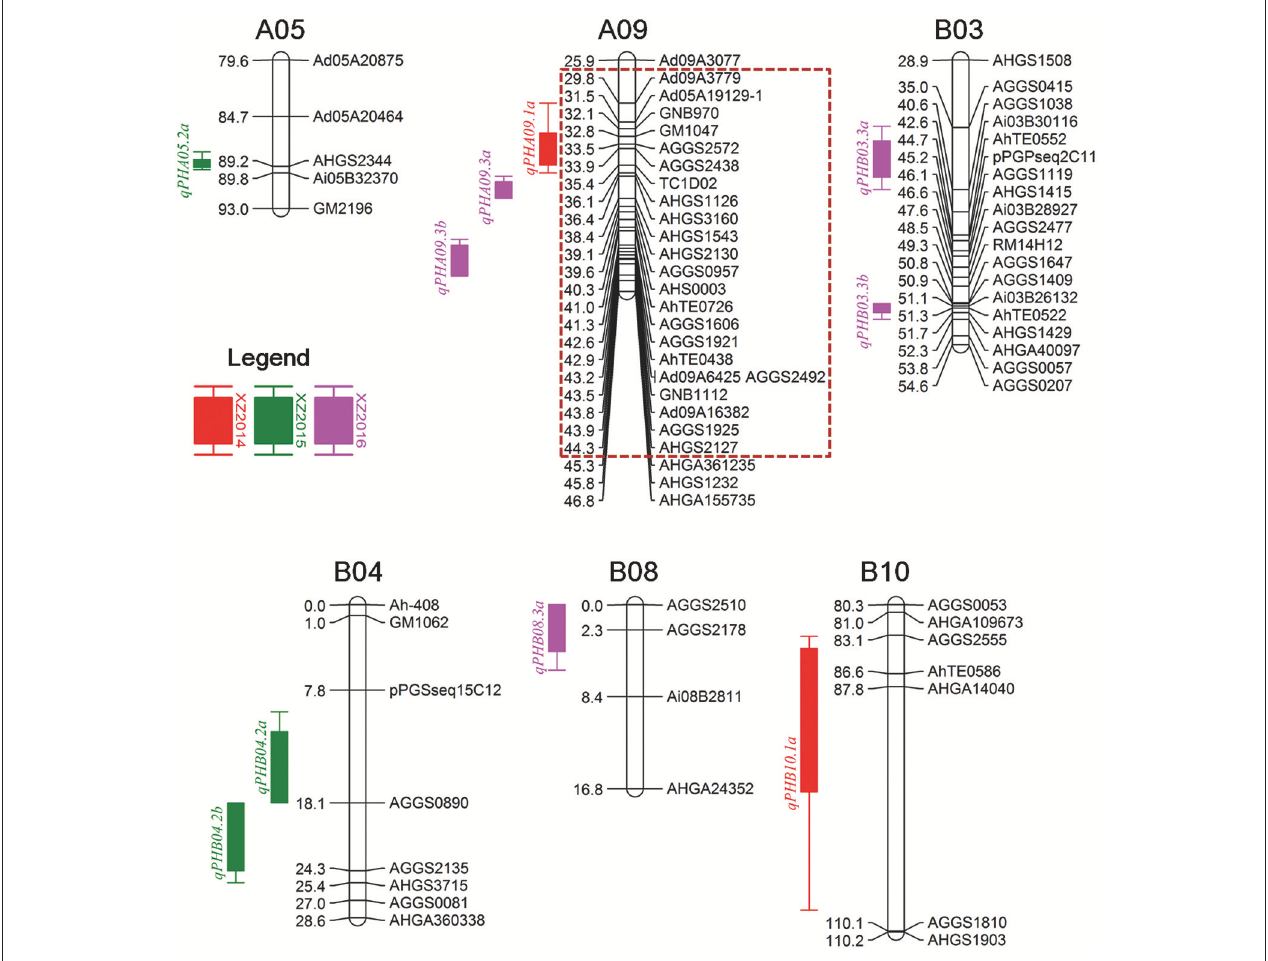
FIGURE 3 | Distribution of QTLs for plant height in the genetic map of XZ population. Dashed box denoted hot spot QTL region. XZ “Xuhua 13 × Zhonghua 6” RIL